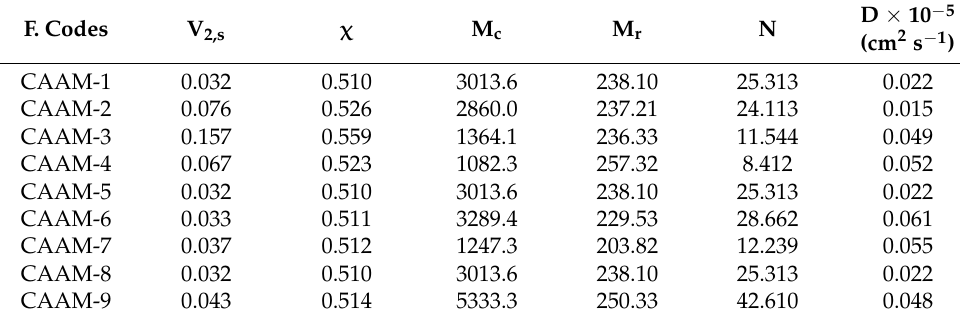
Table 3. Flory–Huggins network parameters of CS- g -AMPS